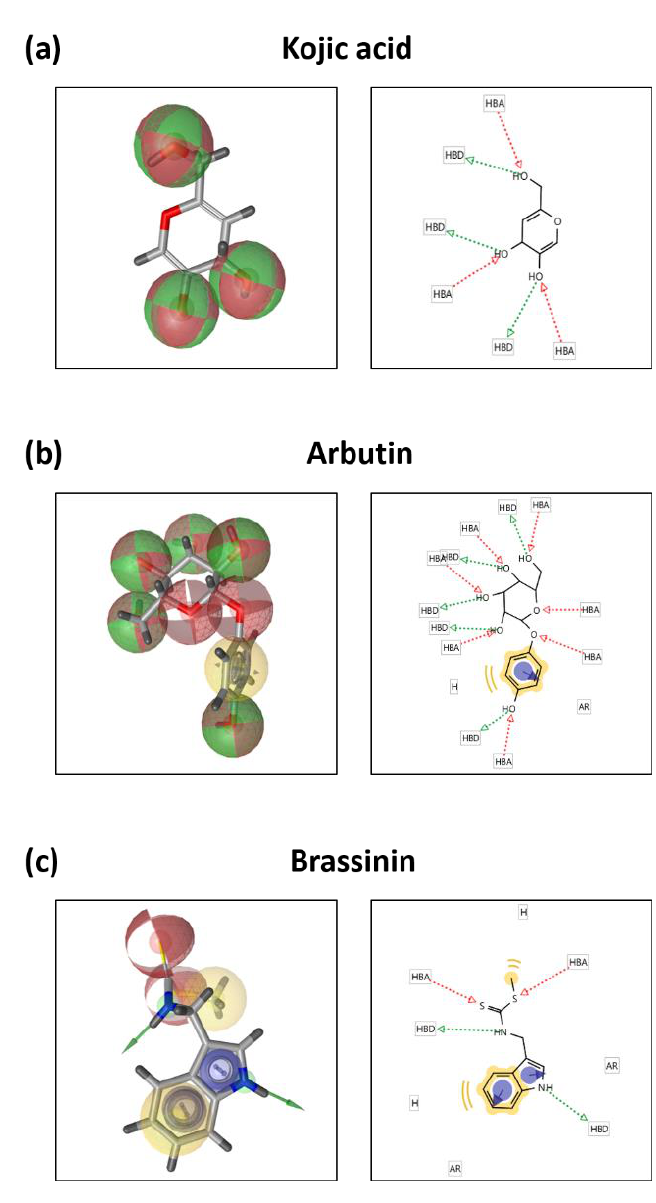
Figure 6. Binding residue analysis of ligands to tyrosinase. Pharmacopoeia analysis of ( a ) kojic acid, ( b ) arbutin, or ( c ) brassinin and tyrosinase was performed using LigandScout 4.4 software.